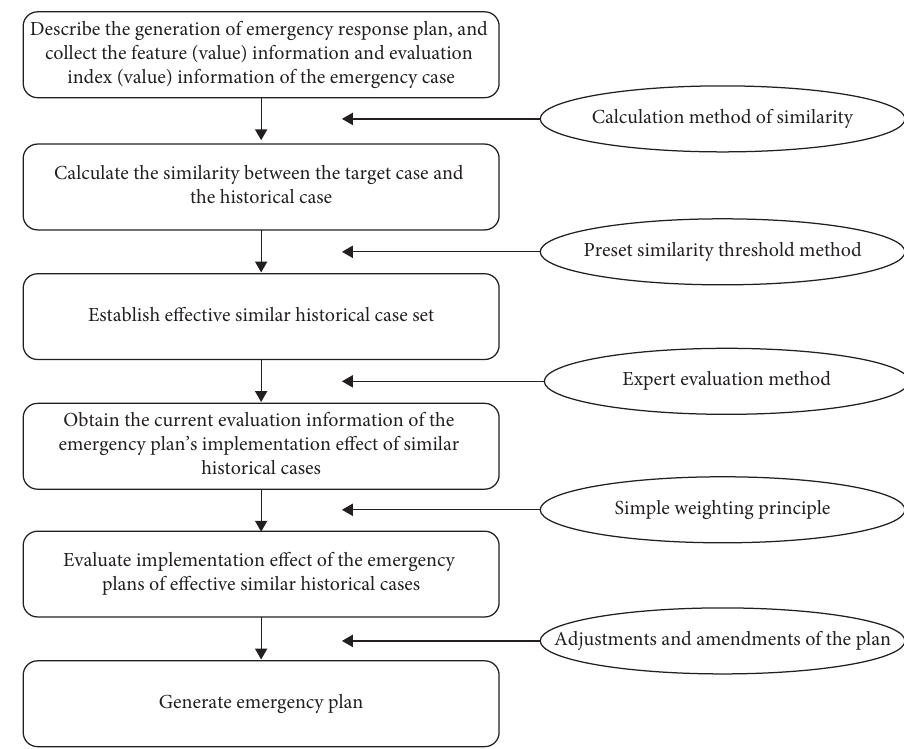
Figure 1: The decision-making process with the proposed